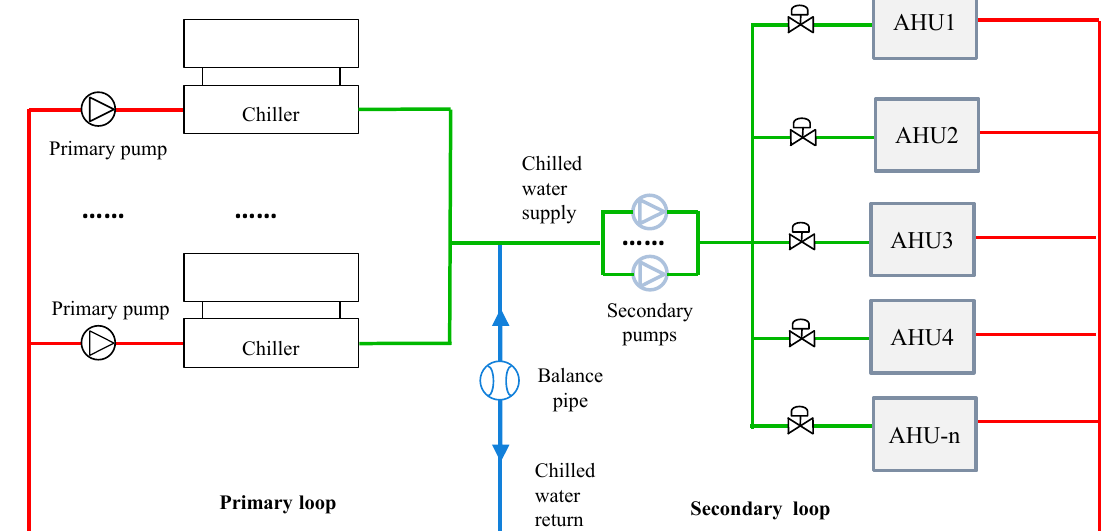
Figure 1. Schematic of a typical primary-secondary chilled water system .